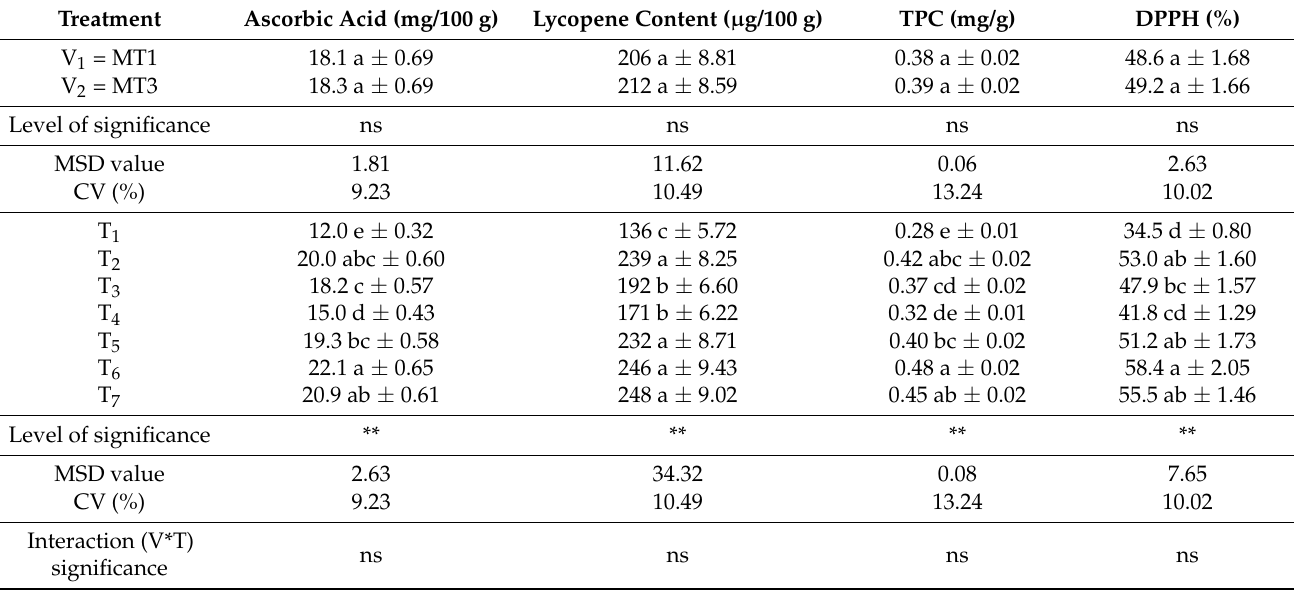
Table 6. Effect of zinc fertilizer and zinc oxide nanoparticles on the quality parameters of two selected tomatoes varieties.